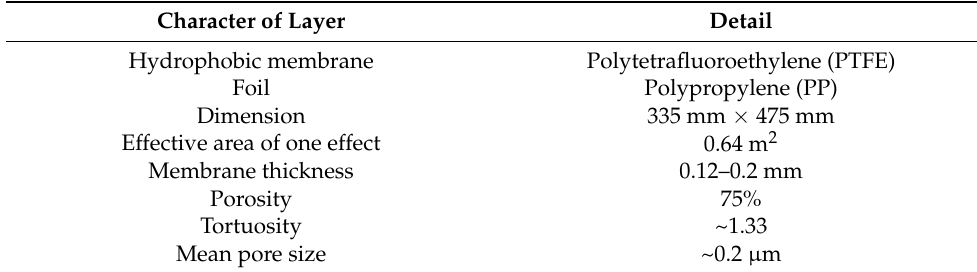
Table 2. Characteristics and specifications of the VMD